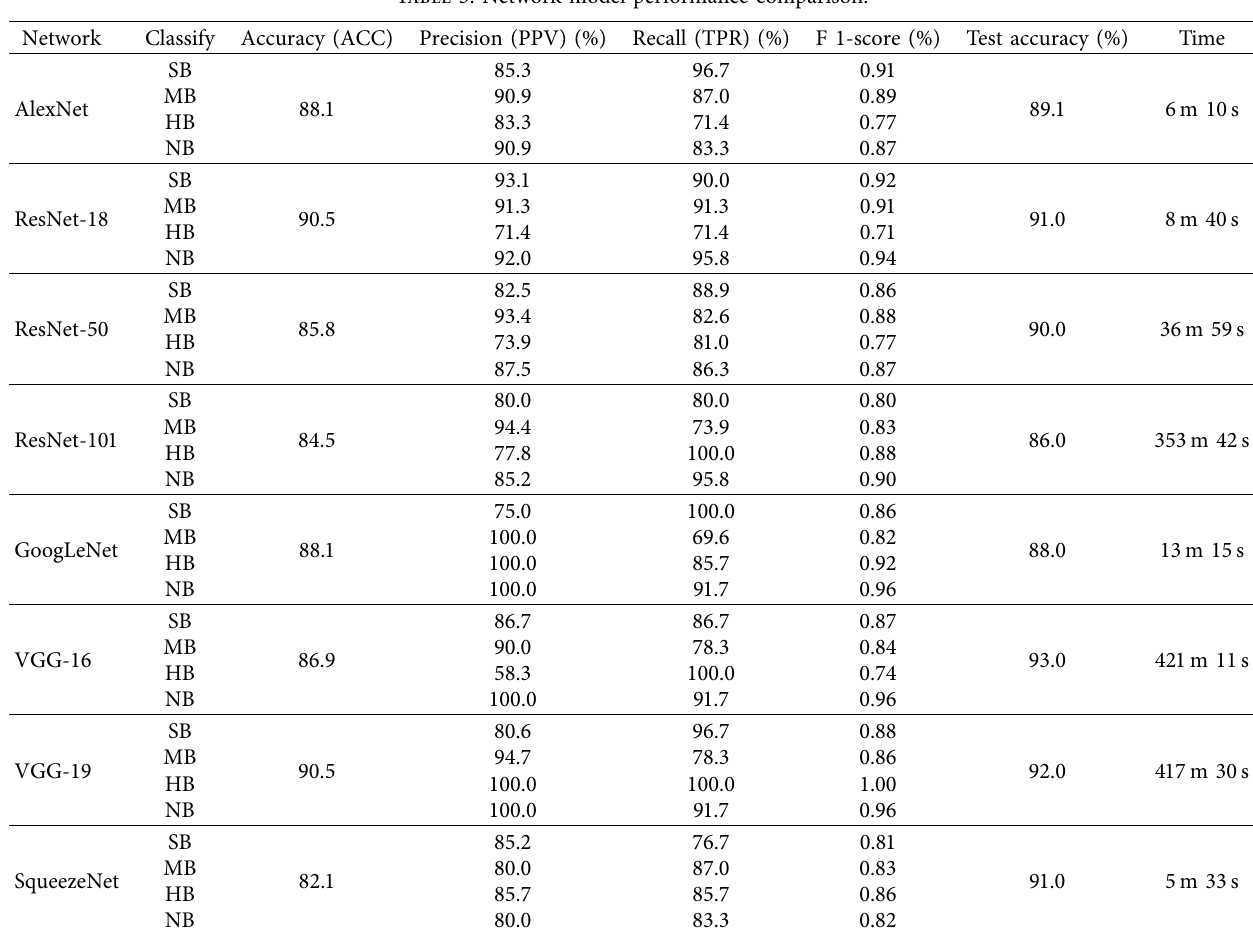
Table 3: Network model performance comparison.